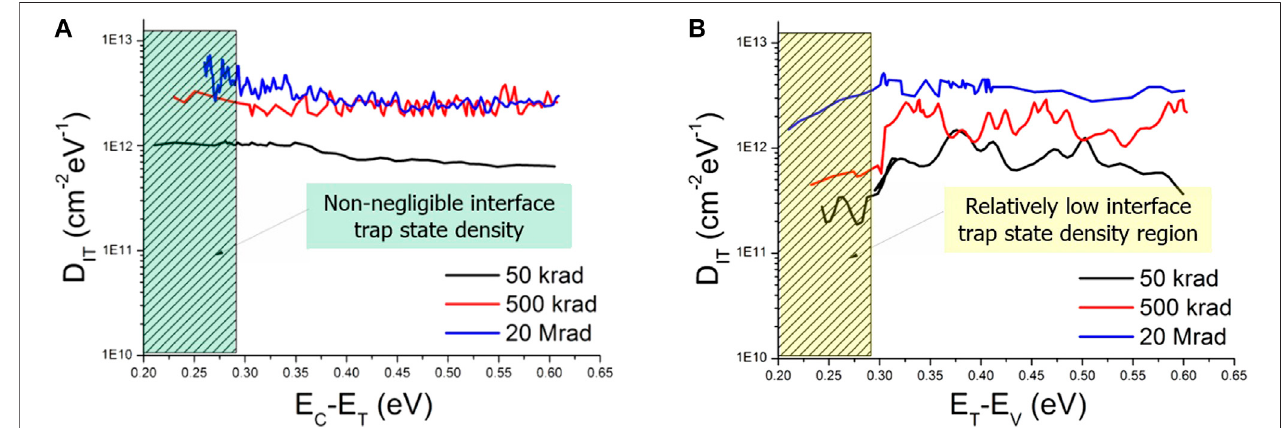
FIGURE 2 | Acceptor-like interface state density D ITacc (cm − 2 eV − 1 ) measured on n-type MOS capacitors (A) , donor-like interface state density D ITdon (cm − 2 eV − 1 ) measured on p-type MOS capacitors (B) , exposed to 0.05, 0.50 and 20 Mrad(SiO 2